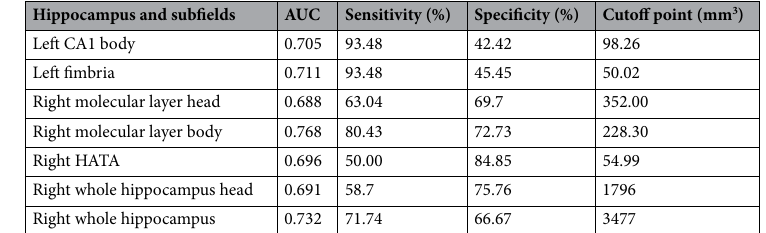
Table 4. ROC analysis for differentiating ESRD patients from HCs. ROC receiver operating characteristic, AUC area under curve, HC health controls, ESRD end stage renal disease, CA cornus ammonis, HATA hippocampus-amygdala transitional